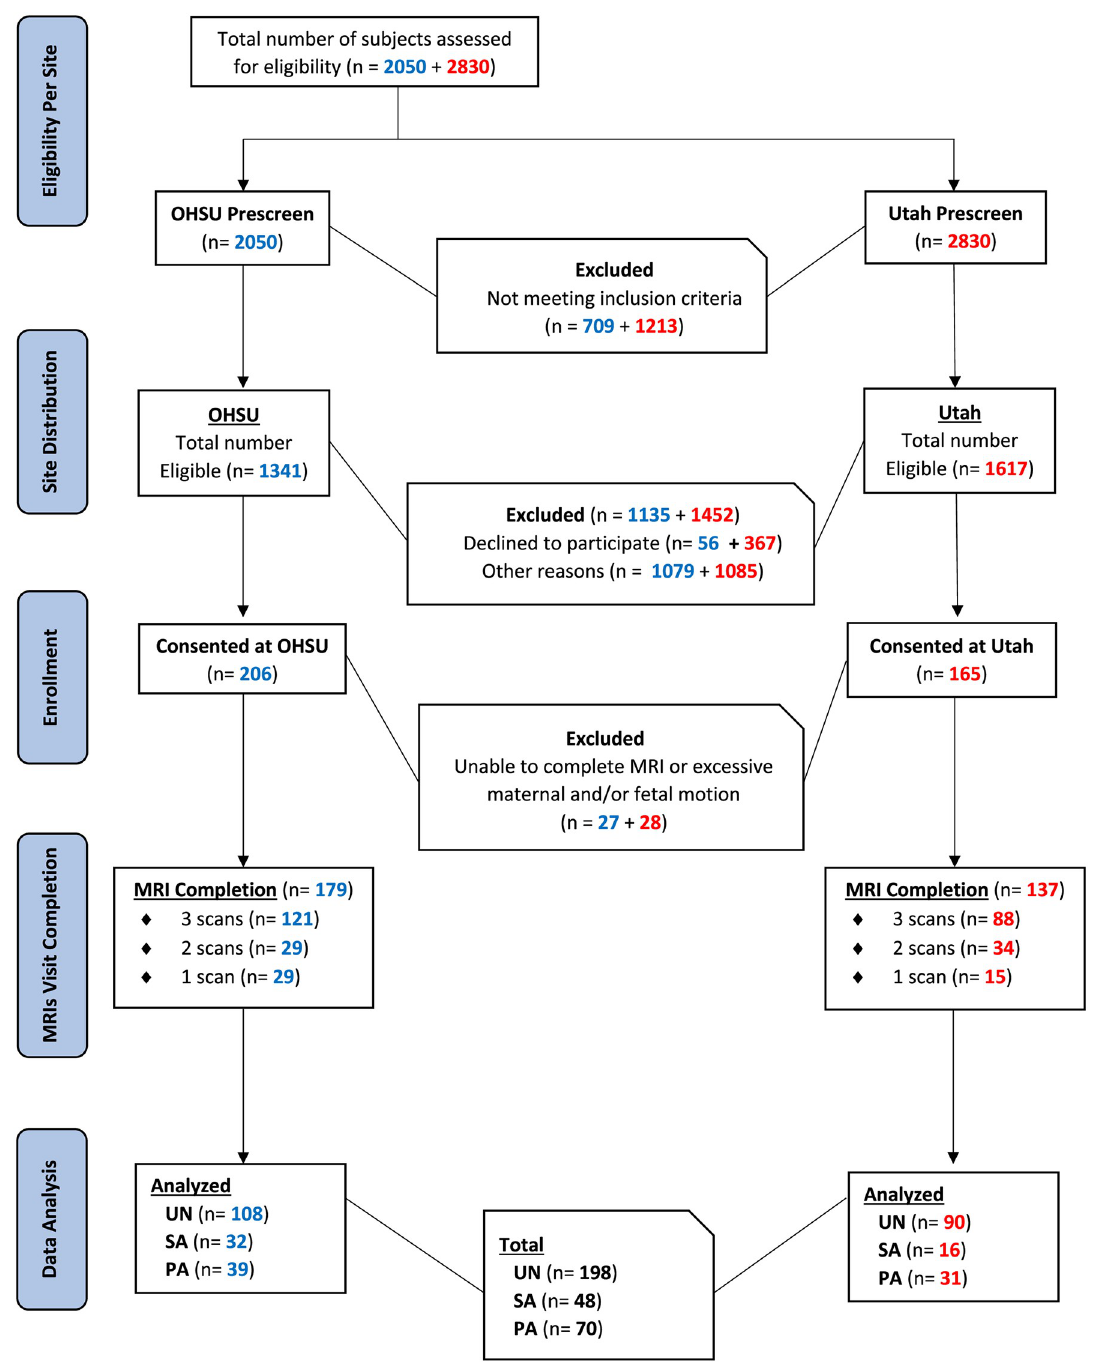
Fig 1. Enrollment flow chart. Numbers detail prospective patients screened, consented, and enrolled at both study sites, along with completed MRI studies meeting quality criteria for inclusion in data analysis presented here. The majority of exclusions were due to lack of child care required to attend study visits, marijuana use and/or concomitant medical conditions.